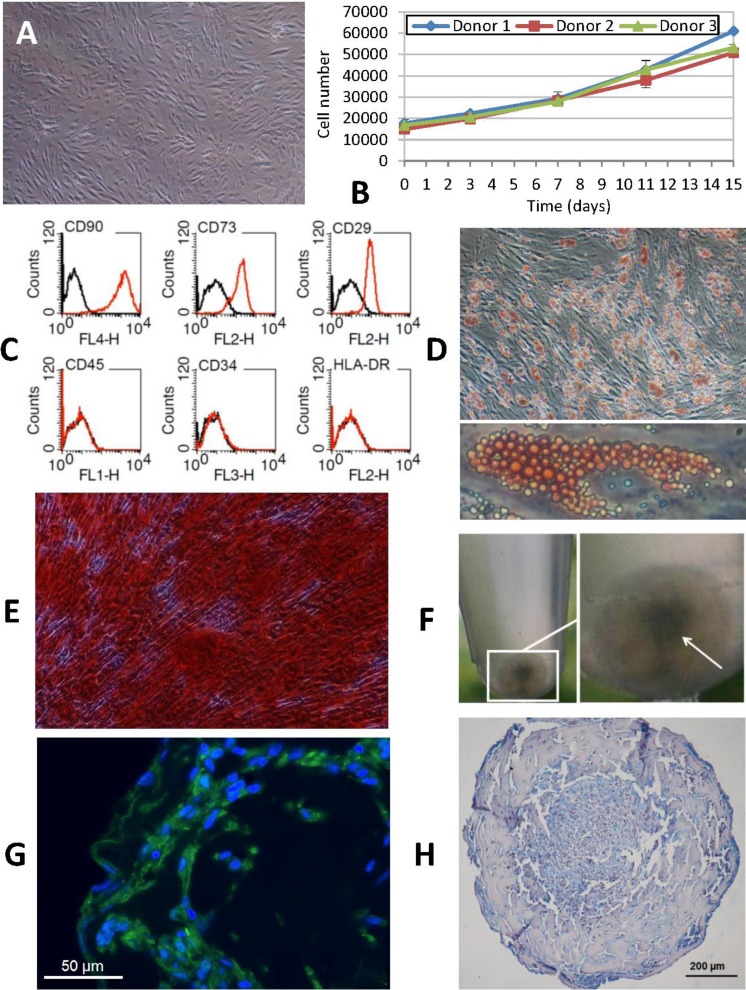
Phenotypic characterization of human ASCs.(A) Cells grown at confluence observed by contrast phase microscopy (original magnification 10×). (B) Growth curves of cell cultures obtained from three different donors showed a similar profile. The initial number of cells plated doubled after approximately 7 days in culture. Cellular proliferation capacity was preserved until the 15th day (without any passages being performed since cell plating). (C) Characterization of ASCs by flow cytometry. An analysis of the expression profile of cell surface-specific antigens showed homogeneity across all analyzed cultures: cells isolated from lipoaspirates expressed typical stromal markers such as CD90, CD73 and CD29 but not major histocompatibility complex class II antigen HLA-DR. Lack of expression of hematopoietic lineage markers CD34 and CD45 was also confirmed. (D) ORO staining shows lipid-filled droplets accumulation by ASCs upon treatment with adipogenic medium (original magnification 20×, zoomed image below). (E) Osteogenic differentiation results in a dense ARS-stained mineralized layer (original magnification 20×). (F) High density cell pellets obtained by the micromass culture technique using Matrigel™ for chondrogenic differentiation. (G) Immunofluorescence staining of aggrecan (green) in the extracellular matrix surrounding ASCs after chondrogenic induction. Nuclei are counterstained with DAPI (blue) (original magnification 40×). (H) Alcian Blue staining of micromass sections shows the accumulation of acid mucopolysaccharides in the extracellular matrix (original magnification 20×).